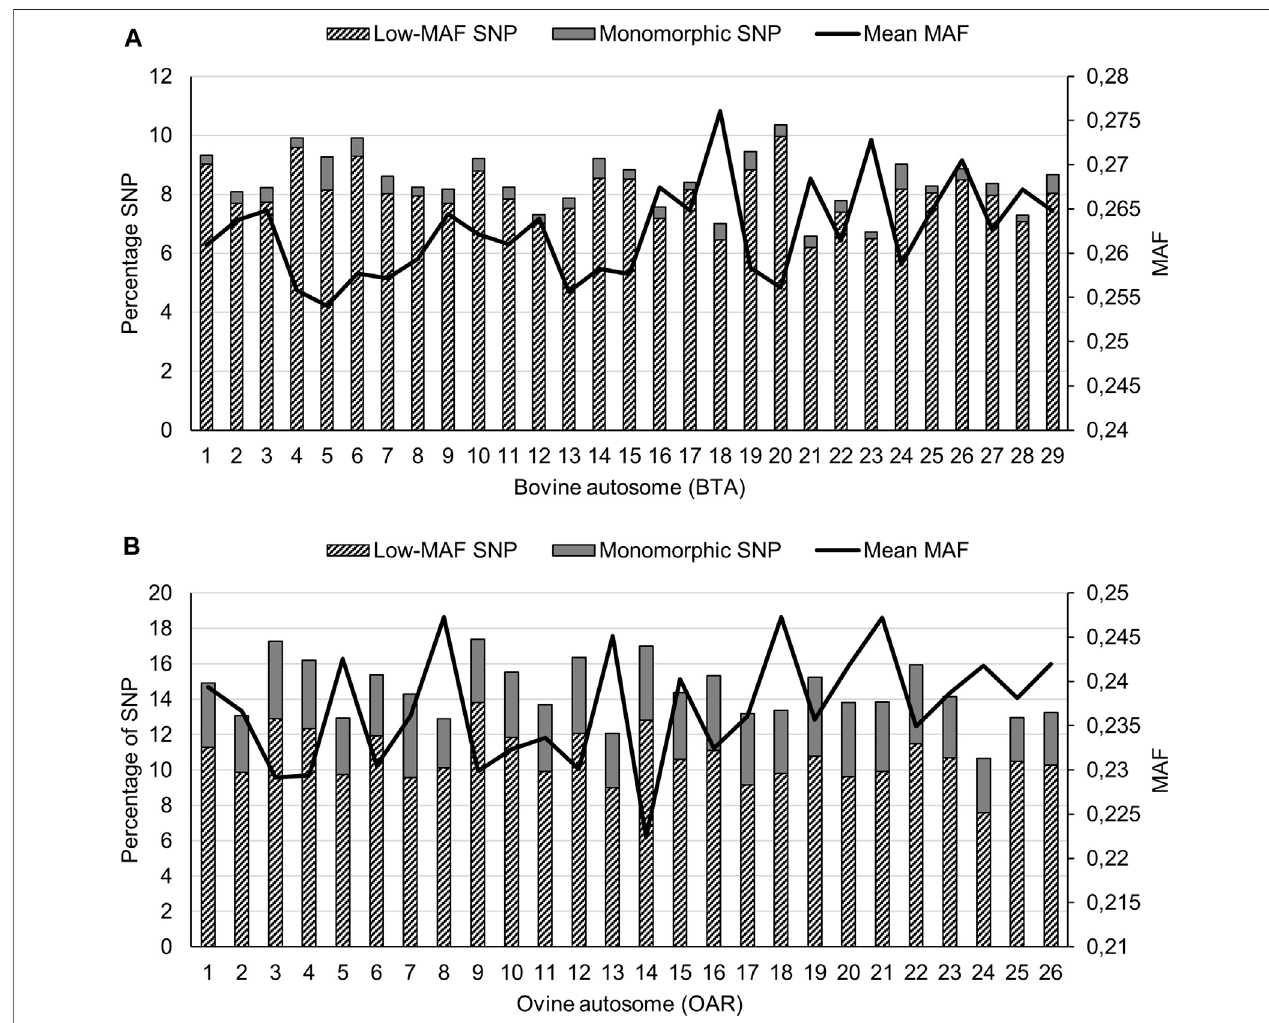
FIGURE 1 | Minor allele frequency (MAF) statistics across cattle (A) , and sheep (B) populations.